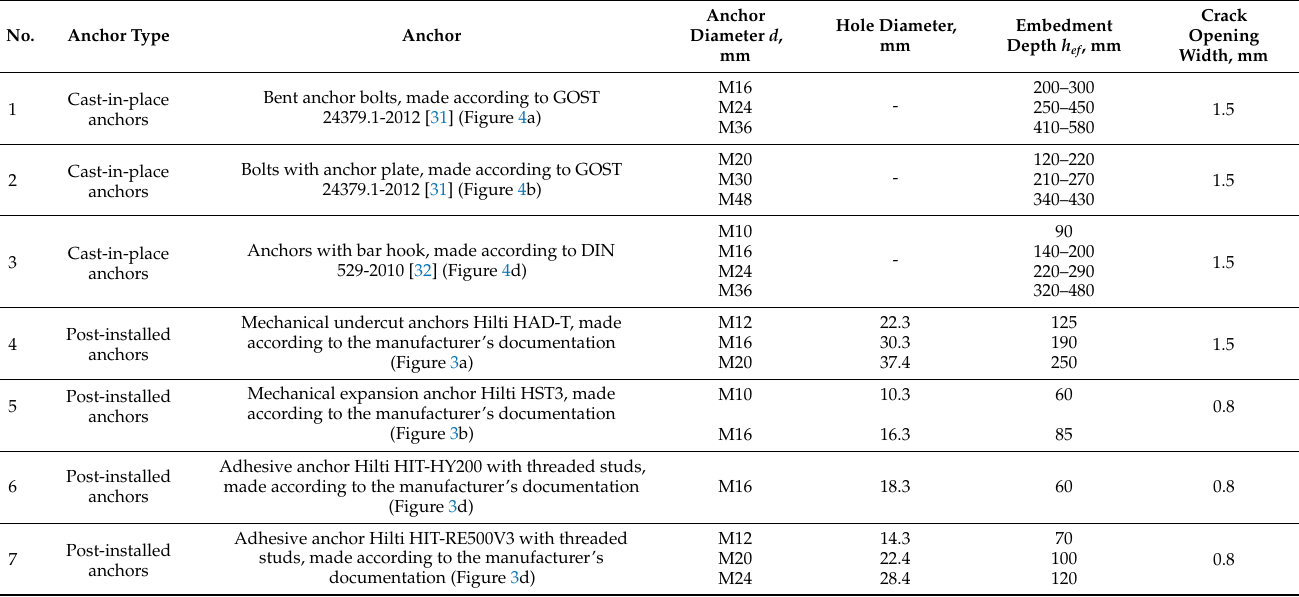
Table 1. Types of tested